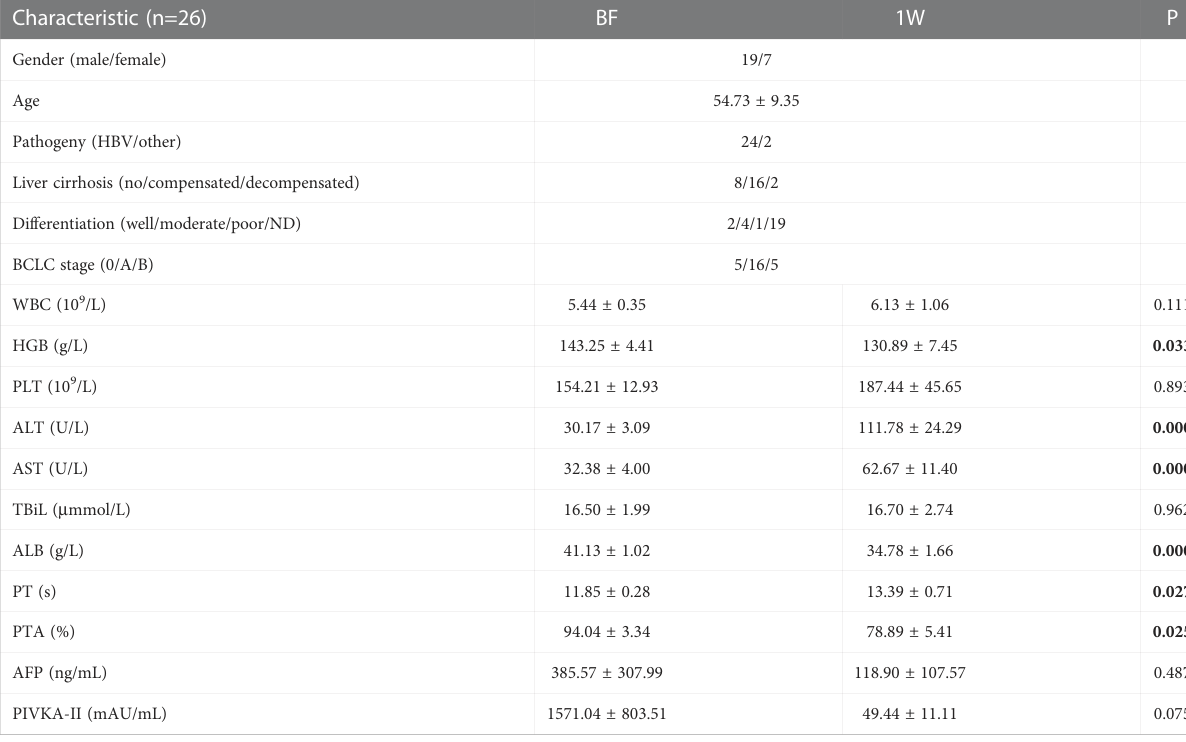
TABLE 3A Characteristics of patients who was detected the BF:1W matched CD8+CD39+ T cells. Characteristic